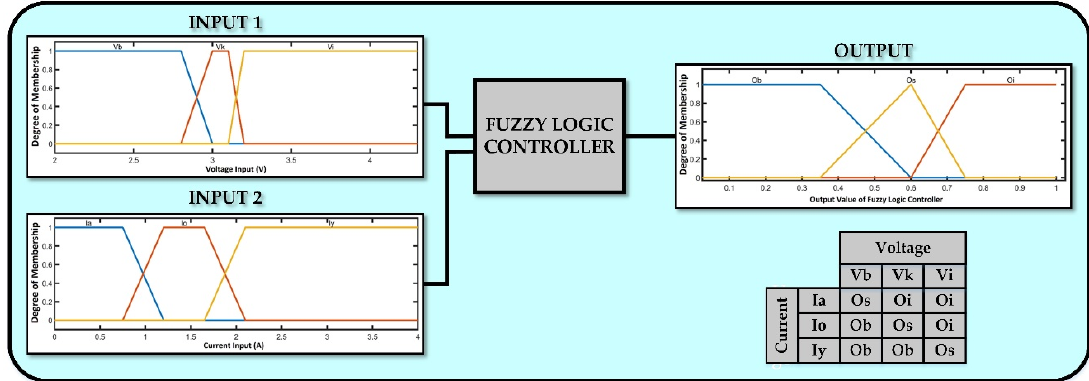
Figure 7. The fuzzy logic controller (FLC) scheme of discharge.